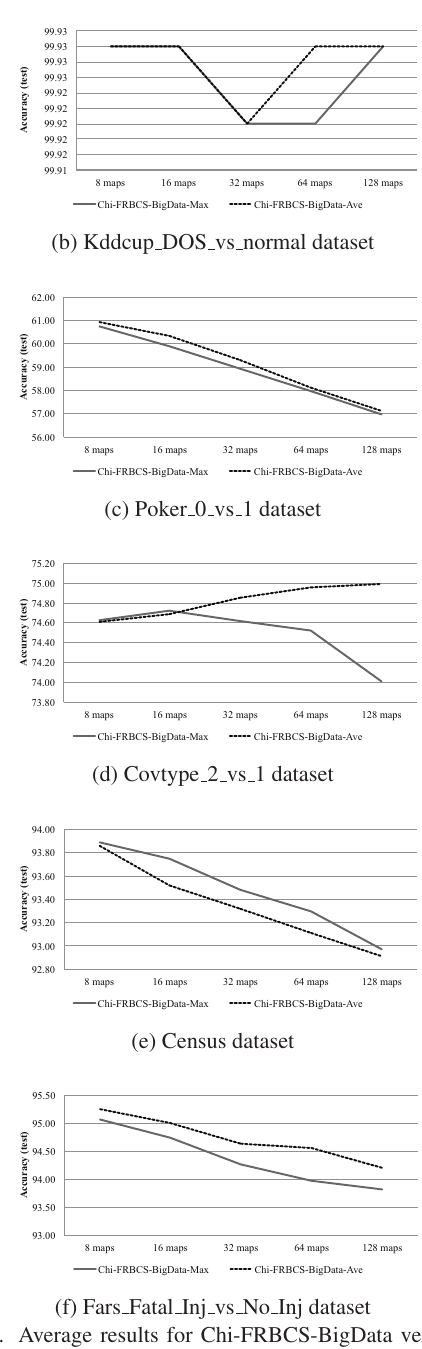
Fig. 6. Average results for Chi-FRBCS-BigData versions using the accuracy